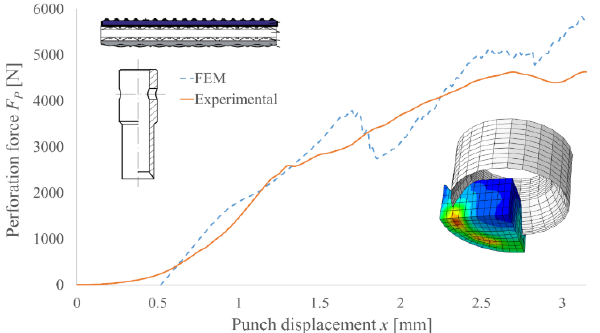
Figure 14. Comparison of the experimental and FEM analysis results of the perforation force for PI punch with diameter d = 10 mm and angle of the blade β = 30° for TFL10S belt.